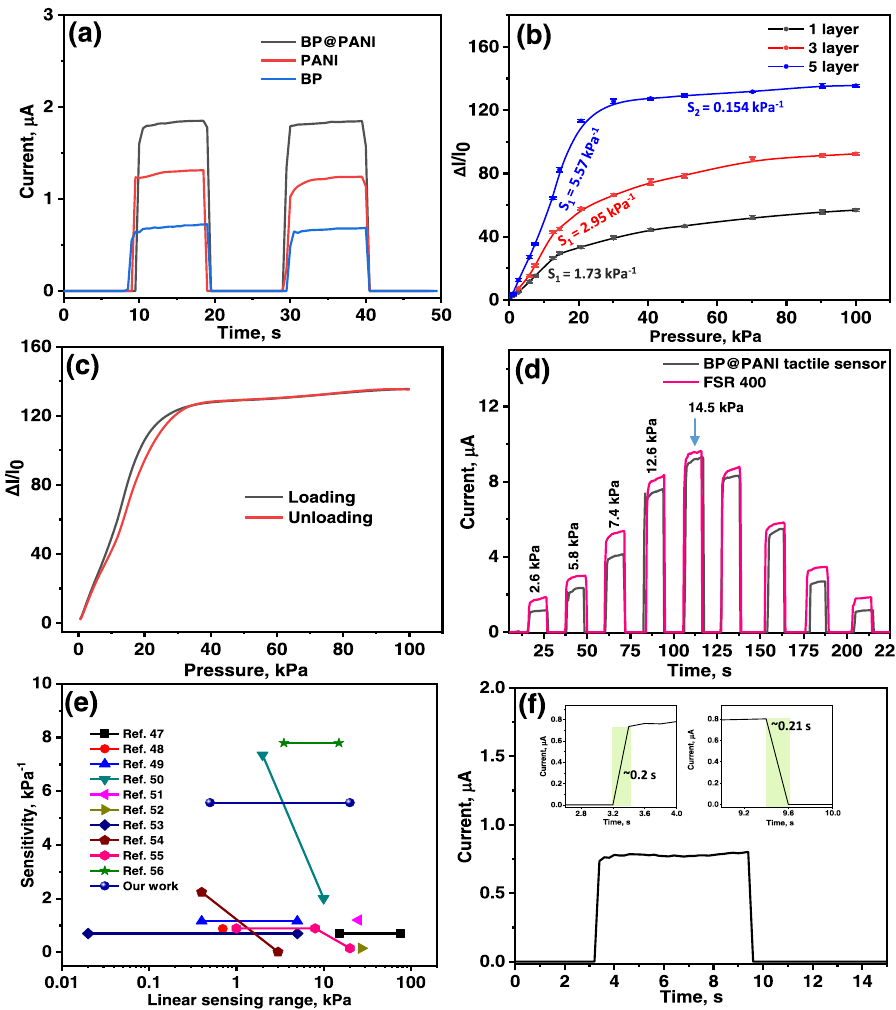
Fig. 3 | Electrochemical performance of BP@PANI-based tactile sensor. a Current response of pristine BP, PANI, and BP@PANI composite (tactile sensor with three layers samples coated fabrics and applied pressure of 5.8 kPa). b Pressure – response sensitivities curves for tactile sensors fabricated with a dif- ferentlayerofBP@PANI-coatedfabrics(Theerrorbarsinrelativecurrentresponse of tactile sensor represent standard deviation based on three measurements).